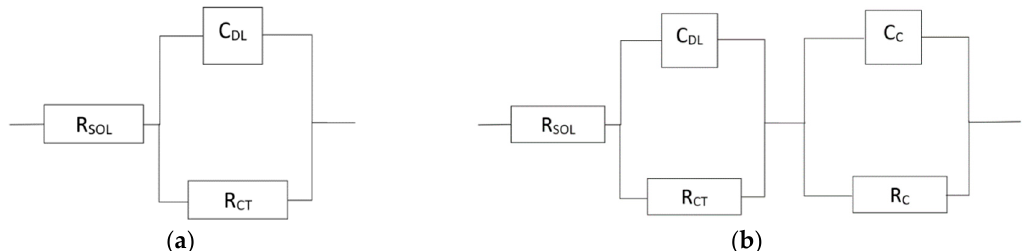
Figure 12. ( a ) Equivalent circuit with one RC couple (active surface), ( b ) Equivalent circuit with two RC couples (passive surface), (RSOL—resistance of the solution; RC—resistance of the passive layer; RCT—charge transfer resistance; CDL—capacitance of electrical double layer; CC—capacitance of passive layer).